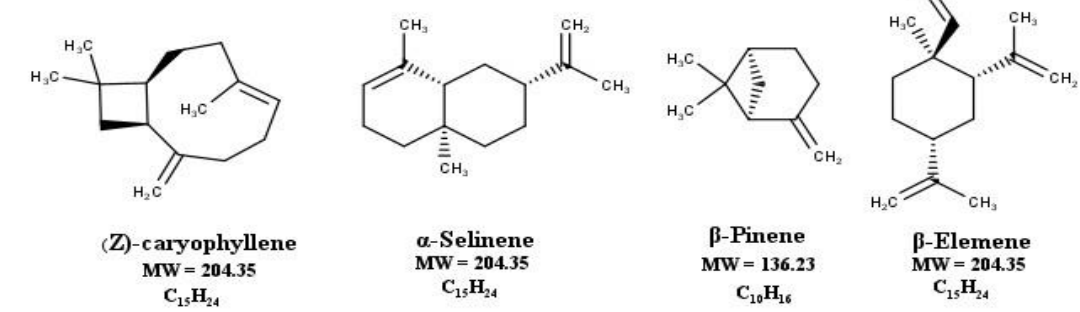
Figure 1. Main abundant sesquiterpene structures identified in the EOAm.